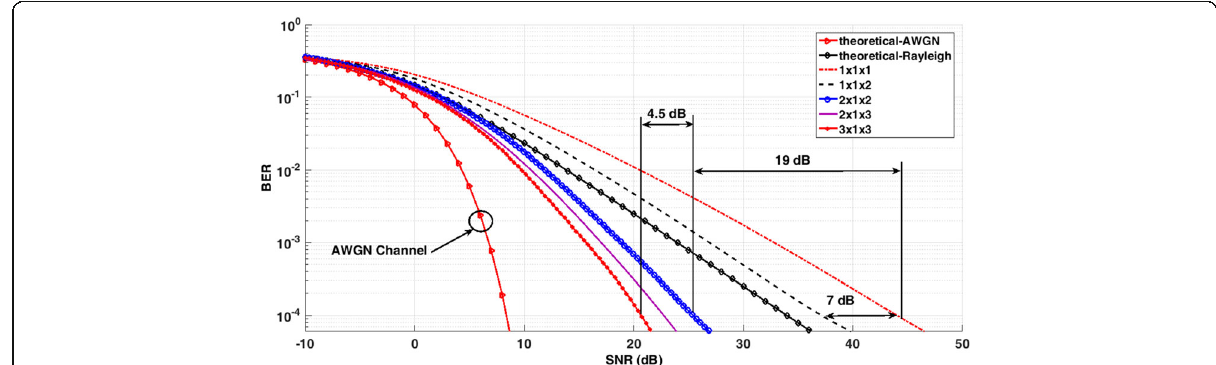
Fig. 11 BER versus SNR for BPSK modulation in the backscatter channel with multiple transmitters and receivers. The transmit diversity in the forward channel is used to add up at the tag location coherently, and the receiver diversity is used in the backward channel with